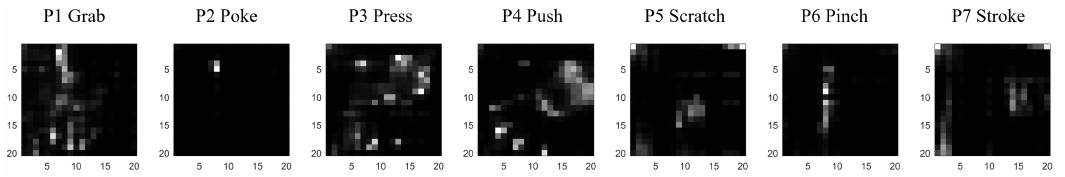
Figure 5. Comparison of the accumulated frame of a random example of every gestures from a random participant. Every pixel in the figure has the summary value of that pixel location within the time window of the